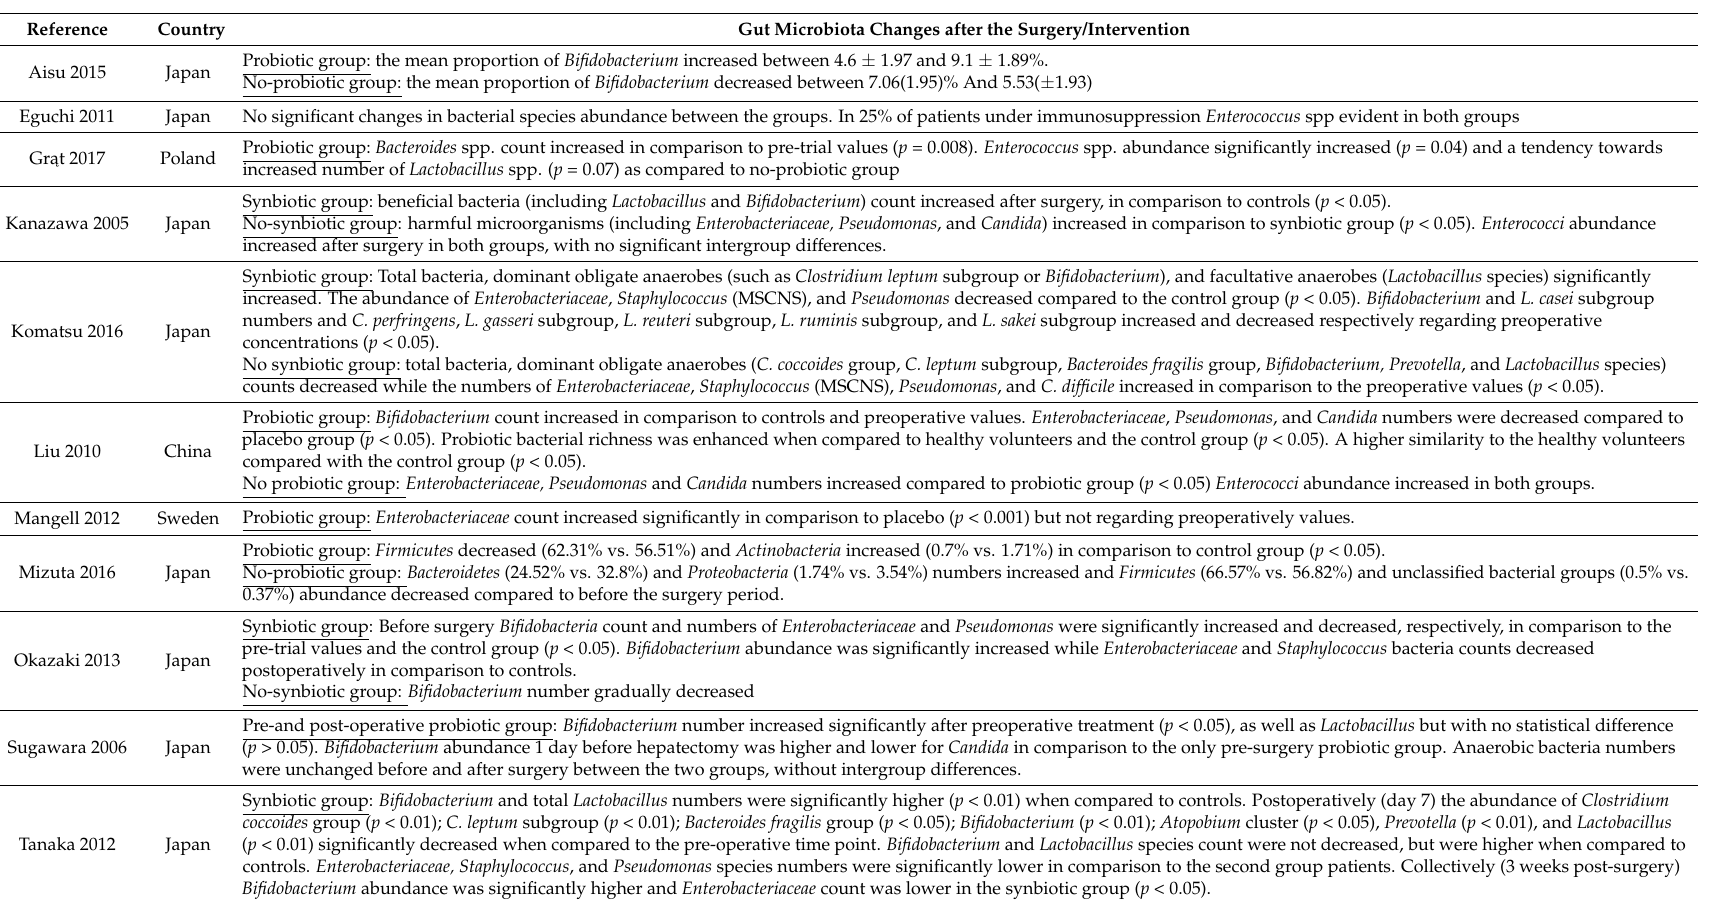
Table 2. Gut microbiota alterations following probiotic